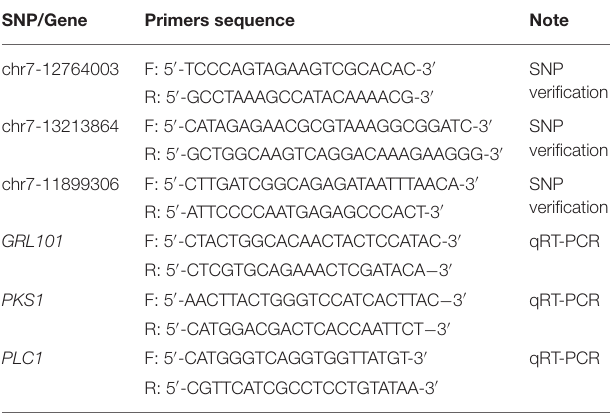
TABLE 1 | Primer sequences used in this